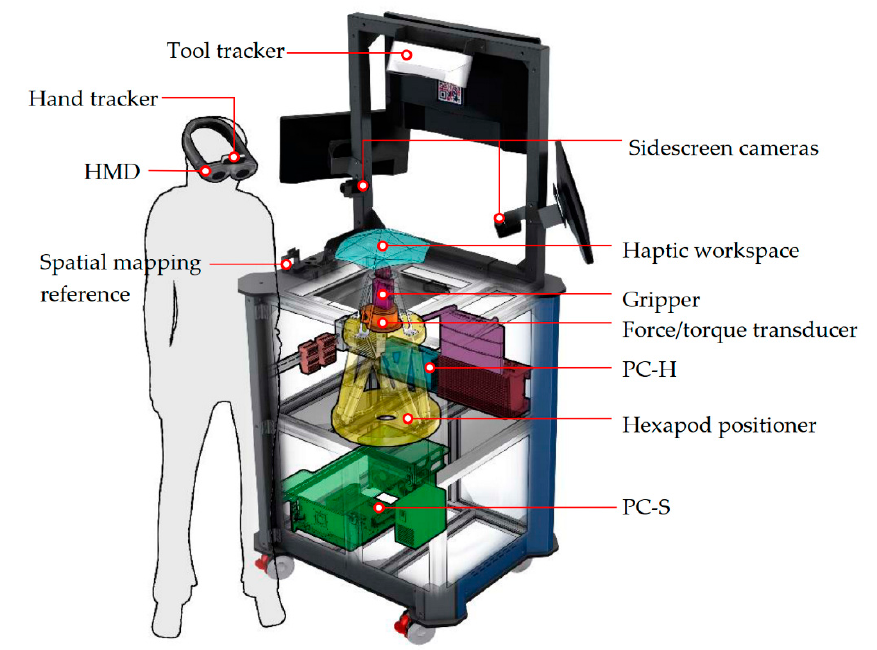
Figure 2. Overview of the VHMR setup. PC-H, hard real-time industrial computer; PC-S, server computer.